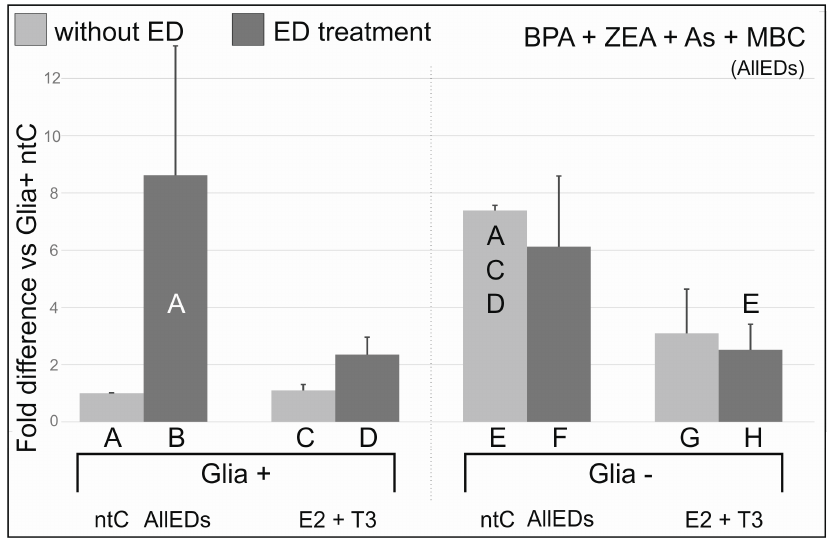
Figure 5. Effects of co-treatments with bisphenol A (BPA), zearalenone (Zea), arsenic (As), and methylbenzylidene camphor (MBC) with, and without 17beta-estradiol (E2) and triiodo-thyronine (T3) on ER β mRNA expression. There was a robust and significant increase in ER β mRNA expression in AllEDs treatment group of glia containing (Glia+) cultures, when compared to the ntC. However, high variance in differences were also found. In contrast, no increase was found in glia-reduced (Glia − ) samples. ER β mRNA expression values in E2 + T3 + All EDs groups were nearly identical in Glia+ vs . Glia − cultures. Compared to their respective non-treated controls, transcript levels in E2 + T3 + AllEDs cultures doubled in Glia+, while decreased to the one third in Glia − . Letters above the columns indicate significant differences ( p ≤ 0.05) from columns below.